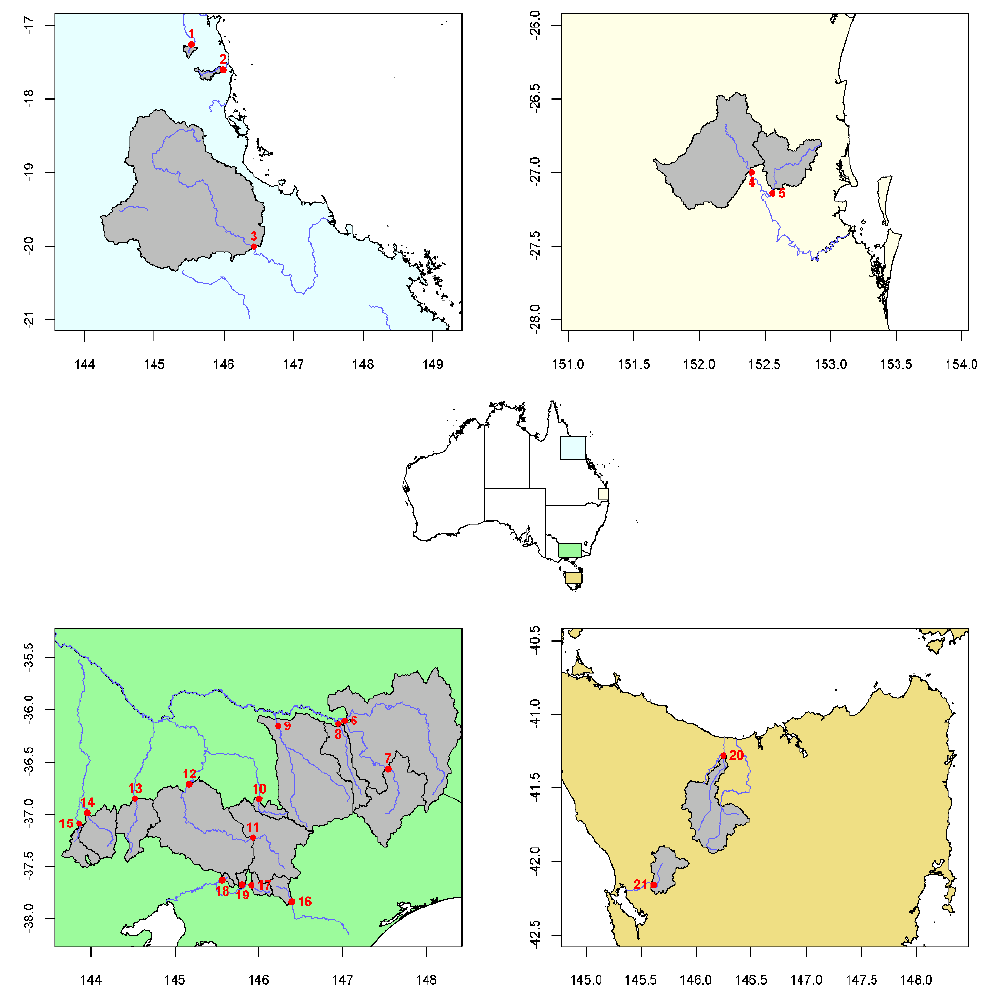
Fig. 1. Location of study catchments (location numbers correspond to identifiers in Table